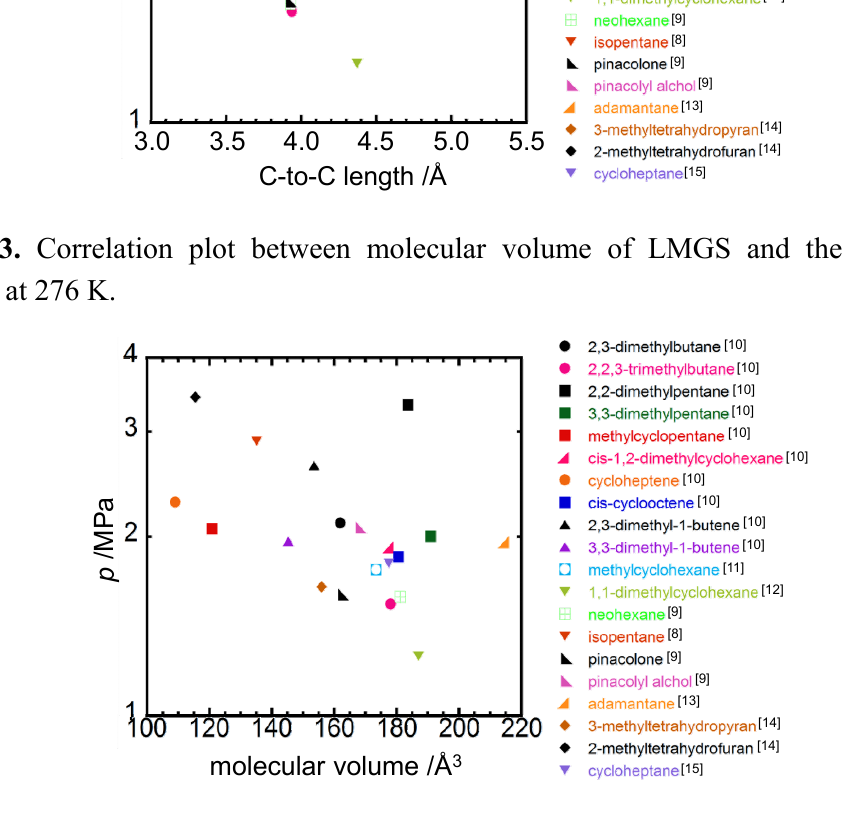
Figure 4. Correlation plot between molar mass of LMGS and the equilibrium pressure at 276